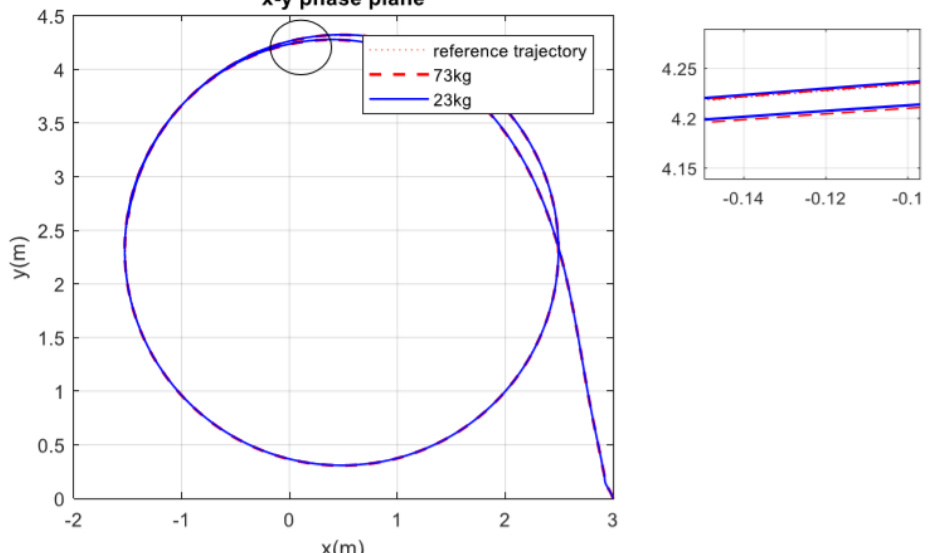
Figure 4. Result of tracking circular trajectory under varying